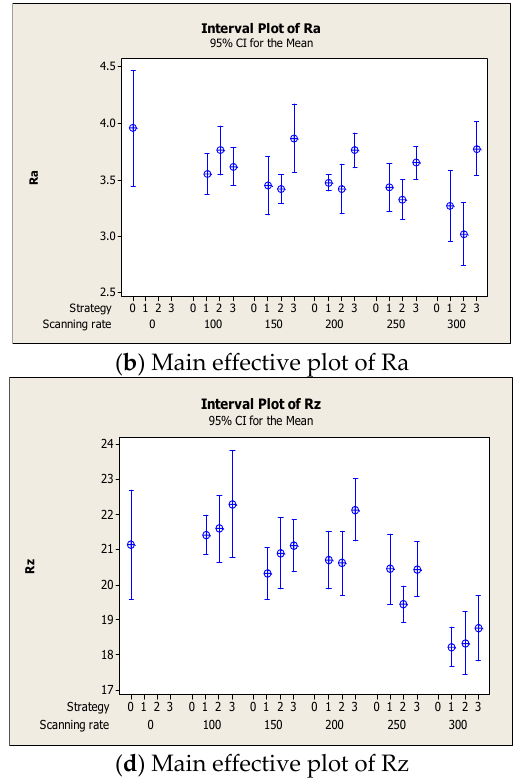
Figure 8. Main results of statistical analysis for the second experimental series. ( a ) AnoVa results for Ra; ( b ) Main effective plot of Ra; ( c ) AnoVa results for Rz; ( d ) Main effective plot of Rz.